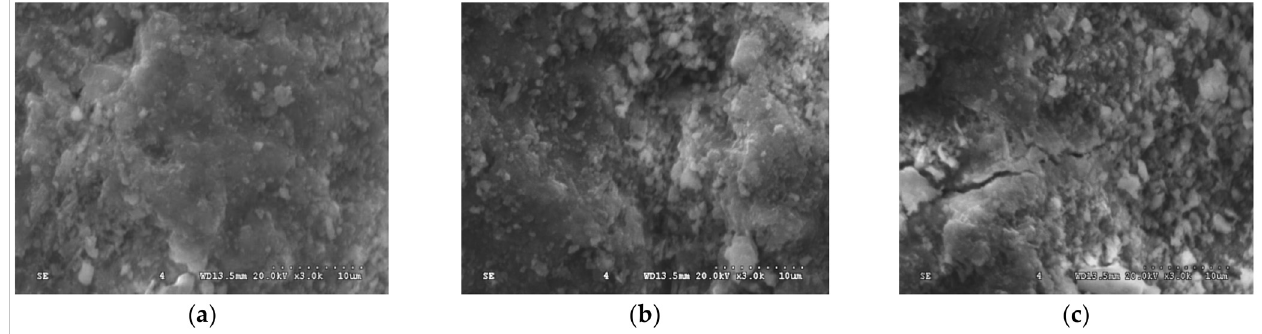
Figure 15. Microstructure of cement paste: ( a ) R0-H0; ( b ) R50-H0; ( c )